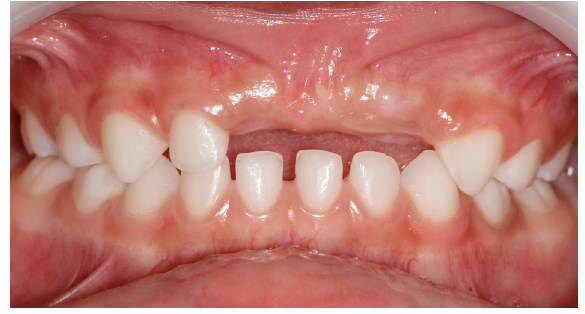
Figure 3. Patient M.C.C., female, 4 years old, premature loss of primary central incisors and lateral incisor (51,61 and 62). Intraoral frontal photograph 6 months after the loss. (Image by Patricia Nadelman PhD student - CVMT/FO-UFRJ ®